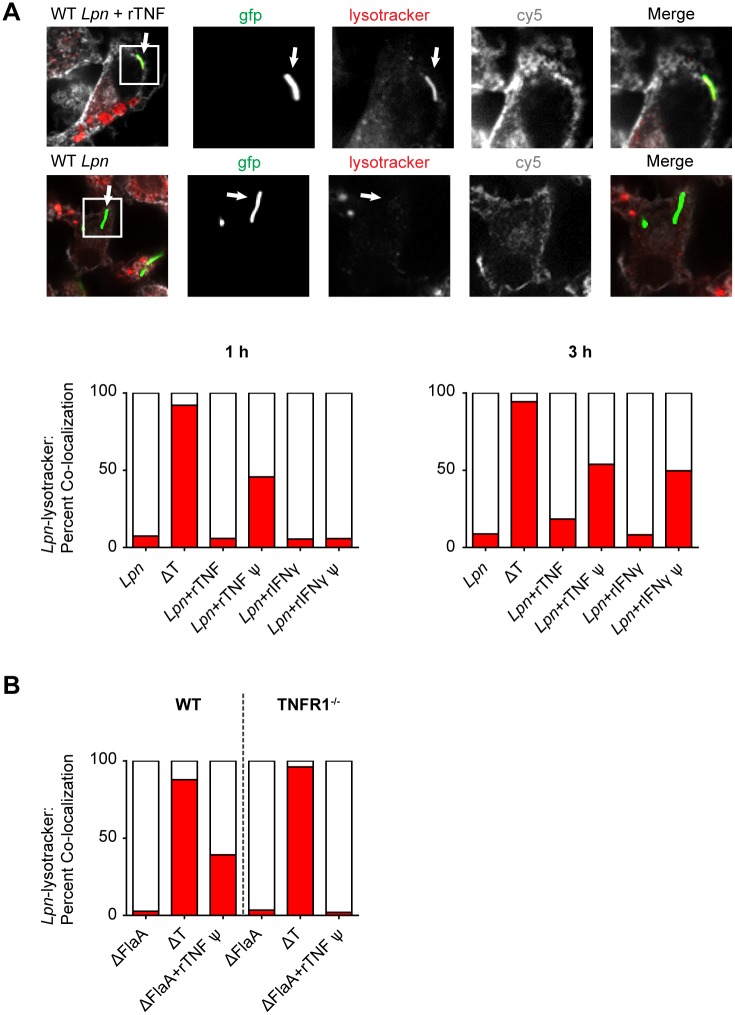
TNF-mediated killing of L. pneumophila is associated with the fusion of LCVs with lysosomal compartments in macrophages.
(A) MN-TNF NAIP5129S1 BMDM were pre-treated overnight with rTNF (rTNFѱ), rIFNγ (rIFNγѱ), or were left untreated, and then infected with Lpn-GFP or ΔT-GFP at MOI 5 with simultaneous addition of rTNF or rIFNγ where indicated. 1 hr or 3 hr p.i. co-localization of Lpn-GFP with lysosomes (stained with lysotracker Red) was analyzed via confocal microscopy, and at least 100 bacteria were counted per group. BMDM cell membranes were stained with Cholera toxin B AF647 (cy5). Data are representative of 2 experiments. (B) WT or TNFR1-/- BMDM were pre-treated overnight with rTNF (rTNFѱ) or were left untreated, and then infected with ΔFlaA Lpn-GFP or ΔT-GFP at MOI 5 with simultaneous addition of rTNF where indicated. 1 hr p.i. co-localization of Lpn-GFP with lysosomes (stained with lysotracker Red) was analyzed via confocal microscopy as in A) and at least 100 bacteria were counted per group. Data is from 1 experiment.